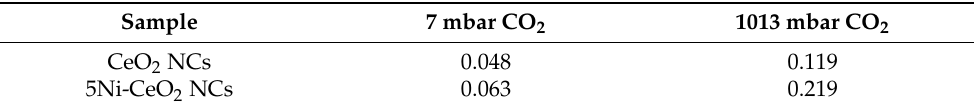
Table 4. Amounts of CO 2 adsorbed on both samples at room temperature. Data are expressed in mmol CO 2 · g − 1